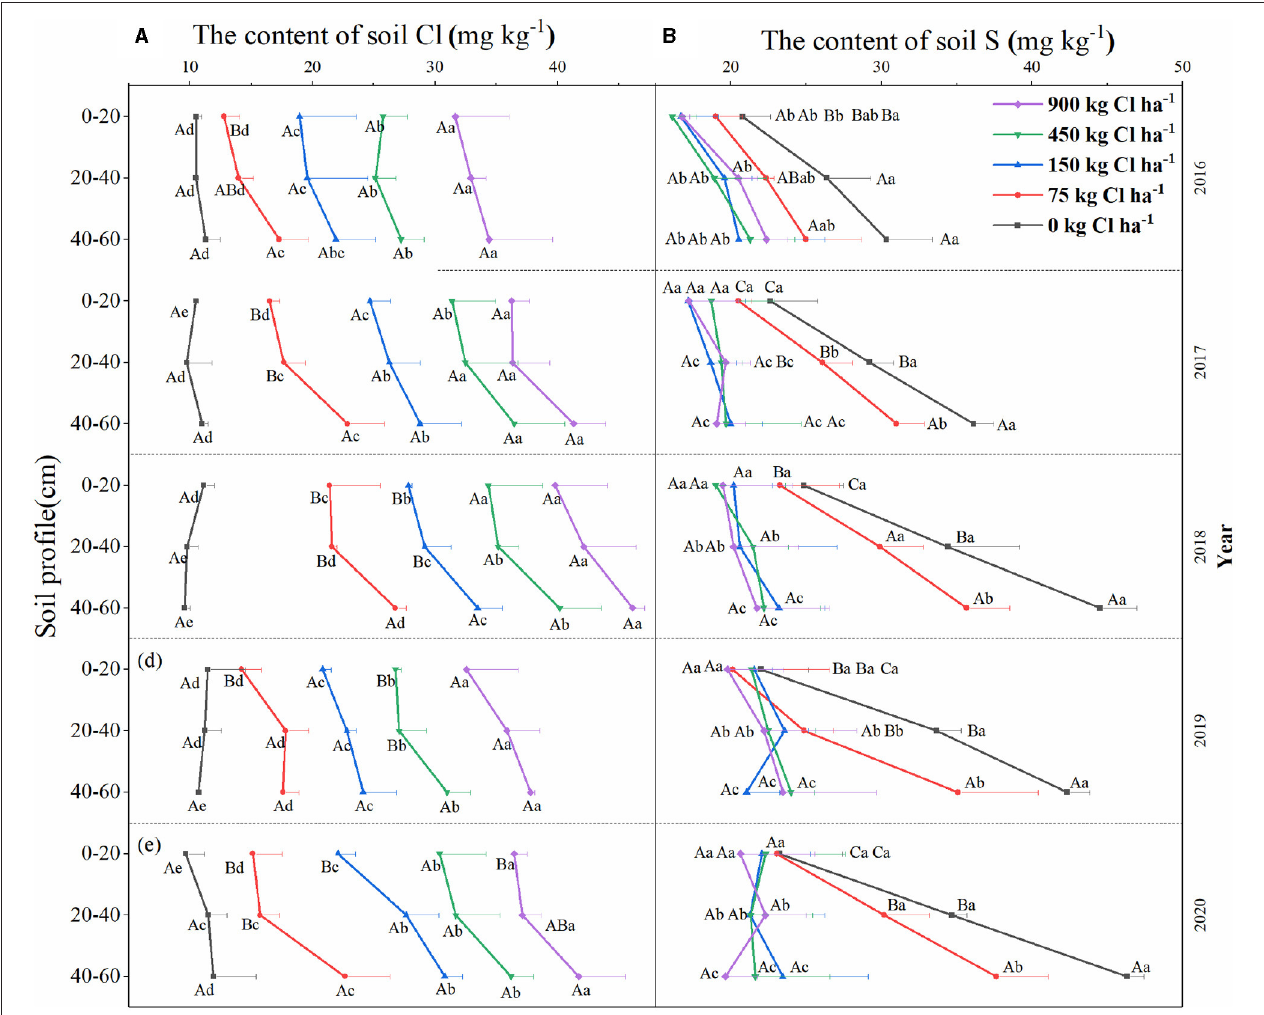
FIGURE 5 | The content of Cl (A) and S (B) changes in 0–60cm soil layer in a 5-year field experiment from 2016 to 2020. Bars are means of three replicates ± SD. The different lowercase letters (a, b, c, d, e) indicate significant differences between the Cl treatment at ( P < 0.05). The different uppercase letters (A, B, C) indicate significant differences between the soil layer at ( P <